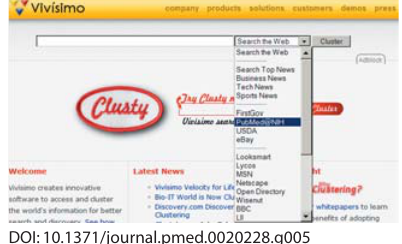
Figure 5. Vivisimo Searches the PubMed Database and Clusters the Results